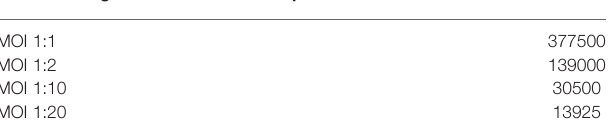
TABLE 1 | Data taken from (15, Table 2), giving the average number of intracellular spores of two replicates of the experiment counted at 1 hour when using spores of a germination-de fi cient strain of